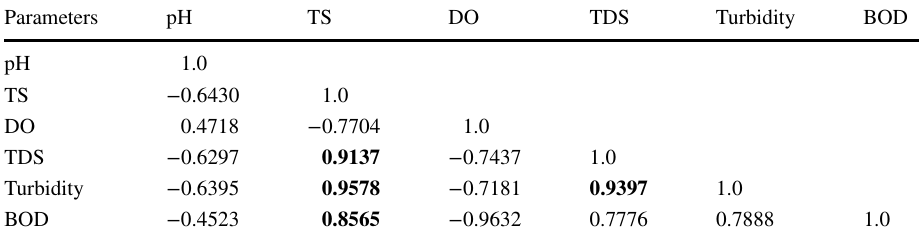
correlation matrix for water samples of Godavari river water in Nashik city (June 2019)